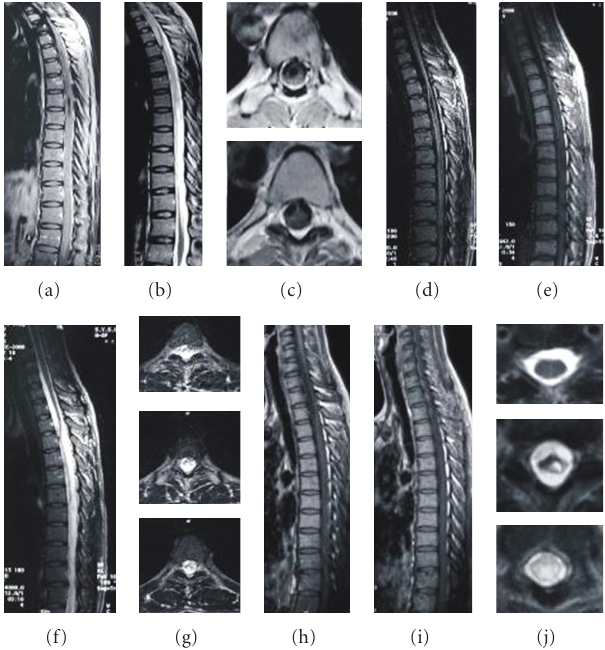
Figure 2: A 25-year-old womanwasadmitted due to the progressive weakness and parasthesia in both legs with voiding problem for 3 months. After 2-year ATT, her situation improved with good recovery of spinal function. The MRI changes are as follows:(a) first MRI performed in August 2005, T1 weighted image showing cord edema from T1 to bottom in the sagittal plane, with focal atrophy and syrinx cavity, (b) T2-weighted image showing a contiguous area of increased signal intensity, (c) cavity and band-like structure on axial T1-weighted images, (d, e) after one year of treatment, the swelling of cervical spinal cord greatly dissolved on sagittal T1-weighted image; the syrinx cavity is obviously diminished, (f) contiguous abnormal signal still left but diminished on the sagittal T2-weighted image, (g) the lesion is still obvious on axial T2- weighted images, (h, i) three years after treatment, the syrinx cavity is not obvious, and (j) some parts of thoracic cord restore normal signal on T2-weighted axial cord images. A small cavity is visible on T8, and increased signal intensity still exists below T9.